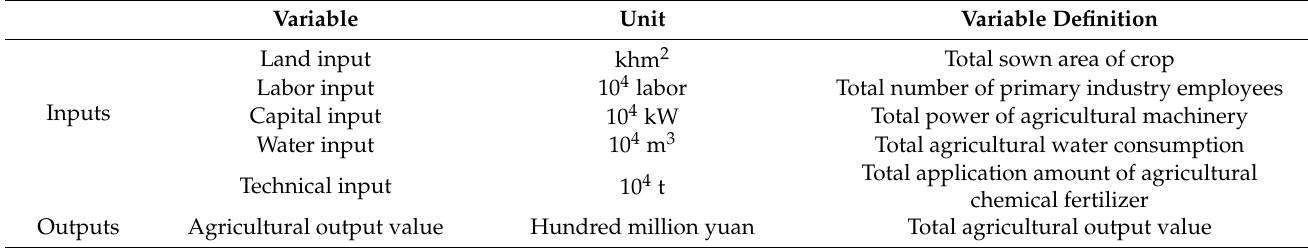
Table 1. Evaluation index system of AWUE (agricultural water use